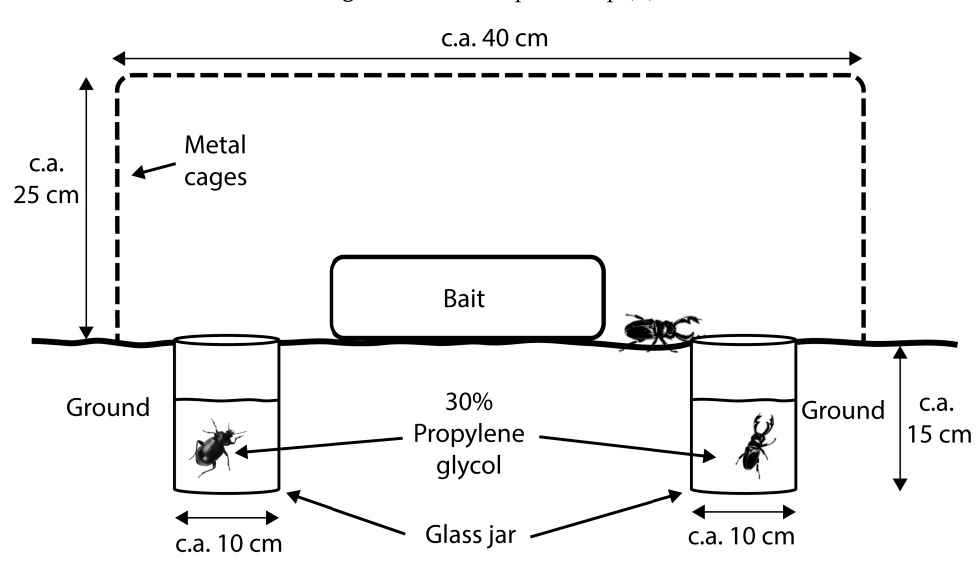
Figure 3. Carrion on surface trap ( L ).